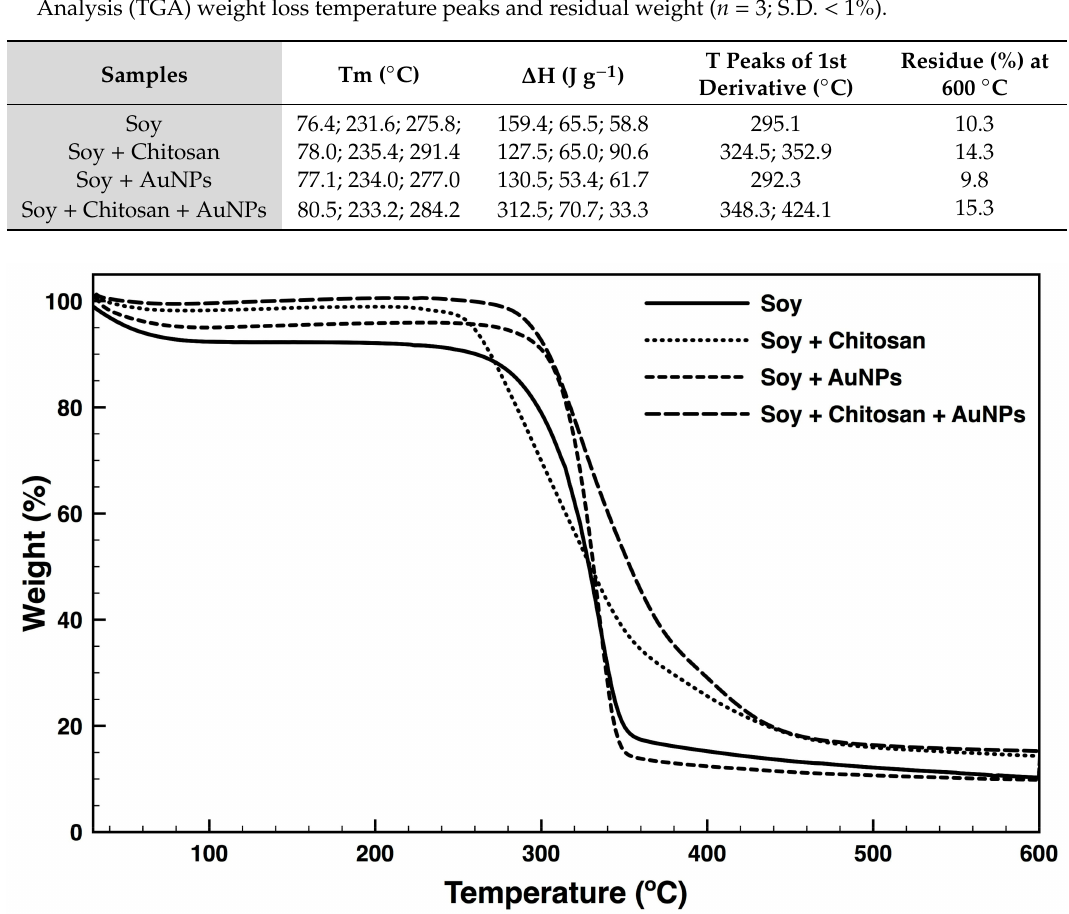
Table 3. Main Di ff erential Scanning Calorimeter (DSC) thermal transitions, Thermal Gravimetric